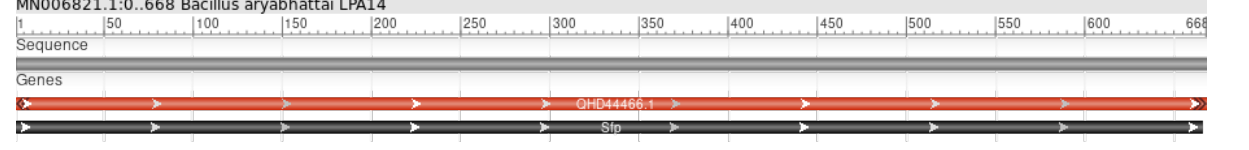
Figure 1. Graphical representation of the lpa-14 (iturin synthesis gene) track with protein features and region features. Sfp- 4′ -phosphopantetheinyl transferase; QHD44466.1 — protein ID (antimicrobial lipopeptide (iturin).